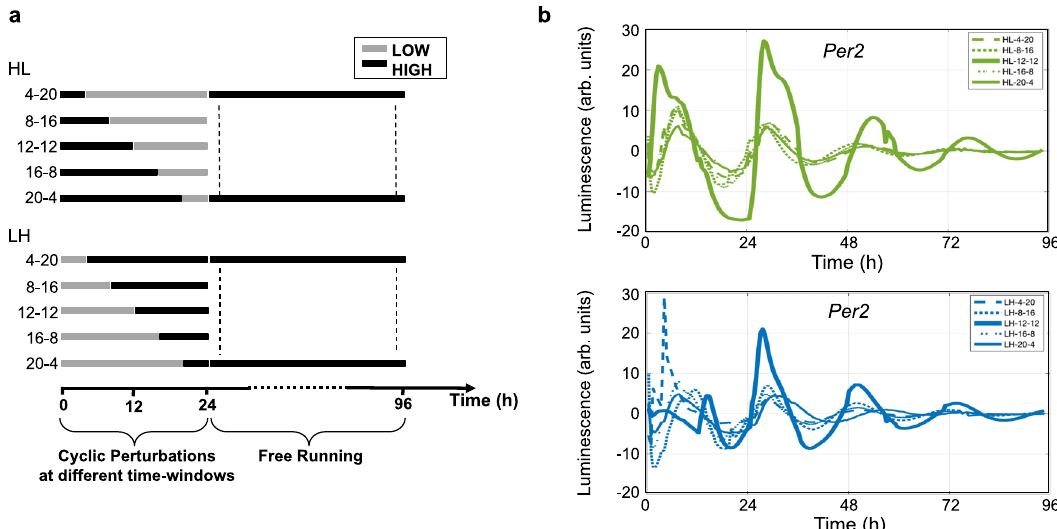
Fig. 2 Circadian behavior under different time-dependent cyclic perturbations. a Schematic representation of daily perturbations under HL or LH cycles imposed at different time-windows (4:20 h, 8:16 h, 12:12 h, 16:8 h, and 20:4 h), followed by a period of FR. b Baseline-subtracted Per2::Luc bioluminescence rhythms of HL and LH imposed at different time windows, was acquired from t = 0 to t = 96 h at intervals of 30 min; data are represented as mean of bioluminescence signal after baseline subtraction, N = 3 for each group. Source data are available as a Source Data fi